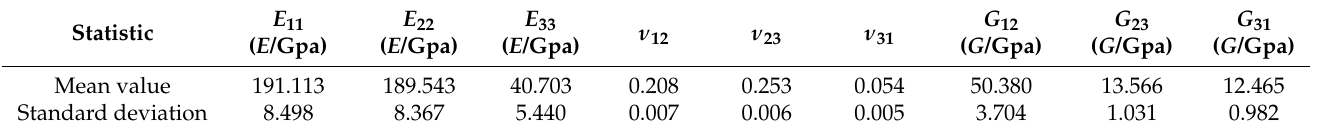
Table 6. Statistics of equivalent elastic parameters of 2D braided composites.